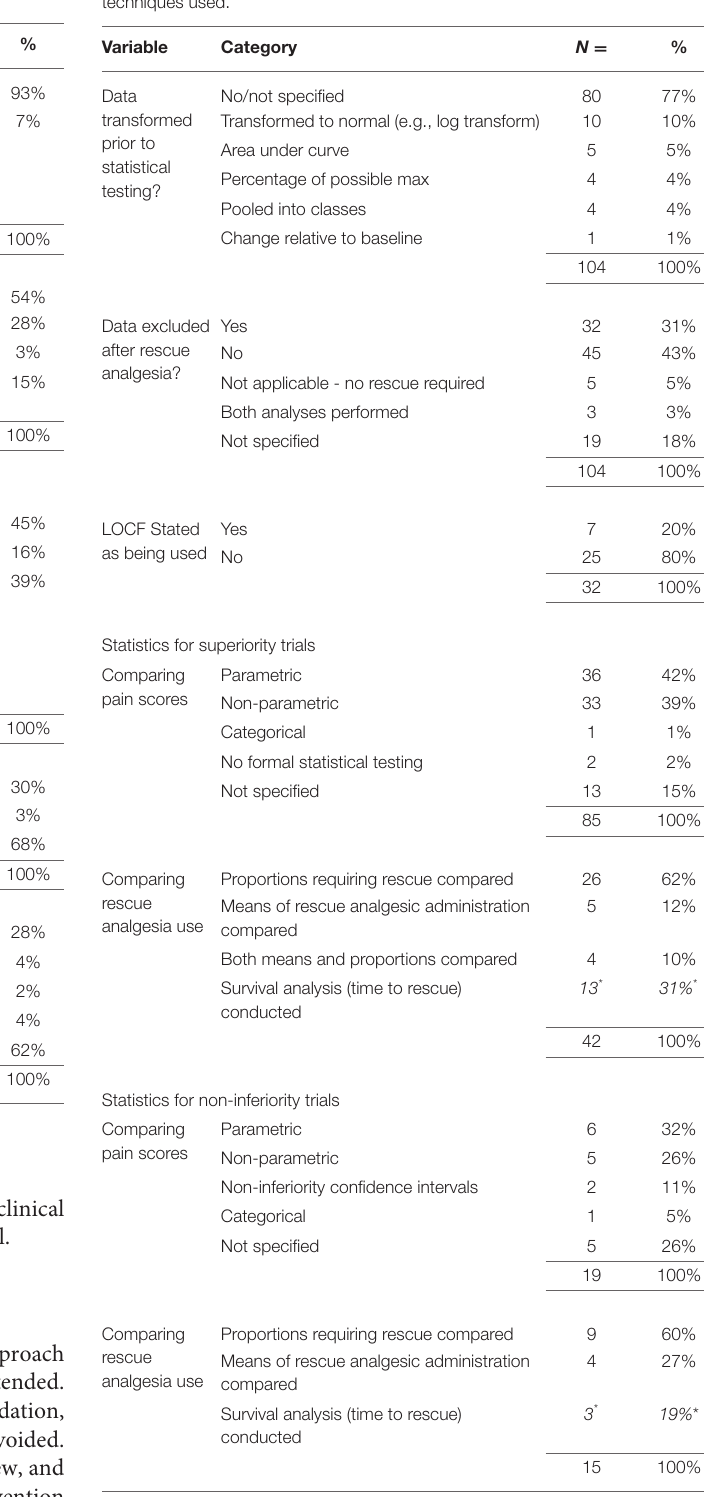
TABLE 3 | A summary of handling data from the CMPS-SF and the statistical techniques